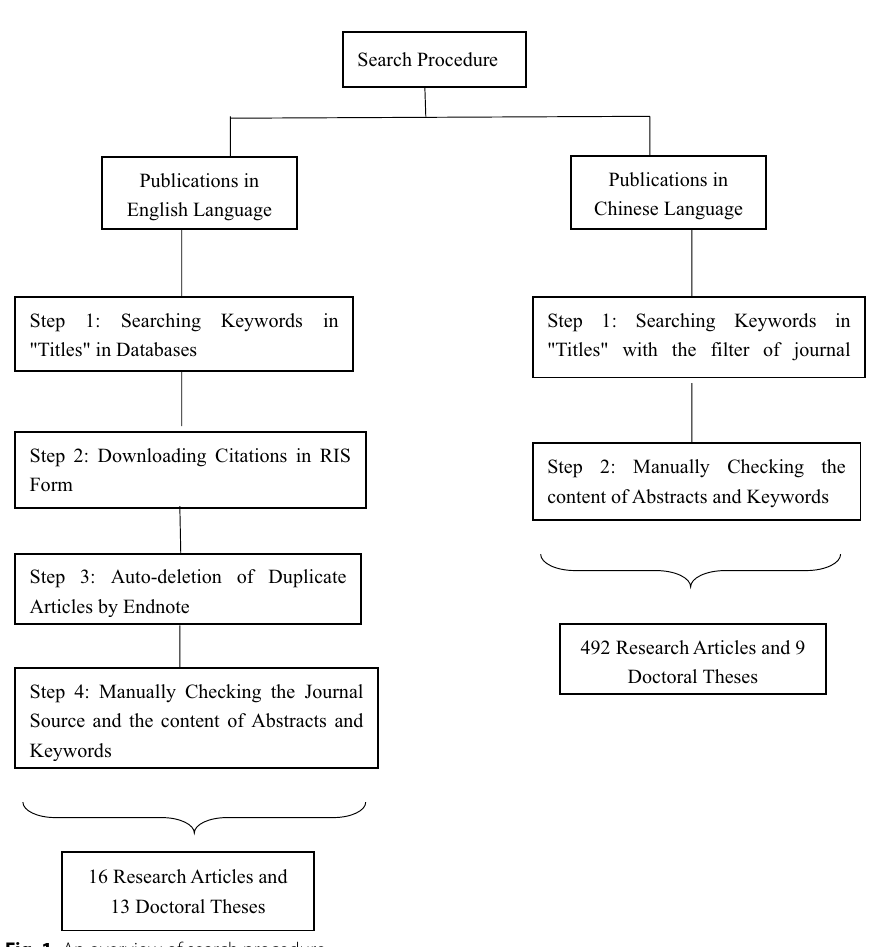
Fig. 1 An overview of search